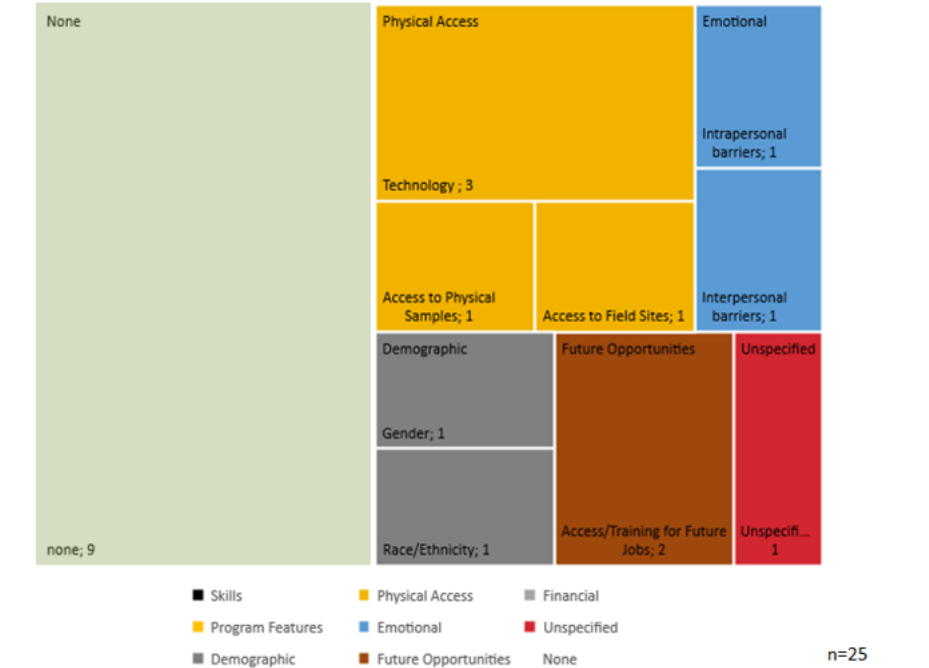
Figure 7. After completing virtual field camp, students had very different perceptions of barriers to succeeding in the field of geology.